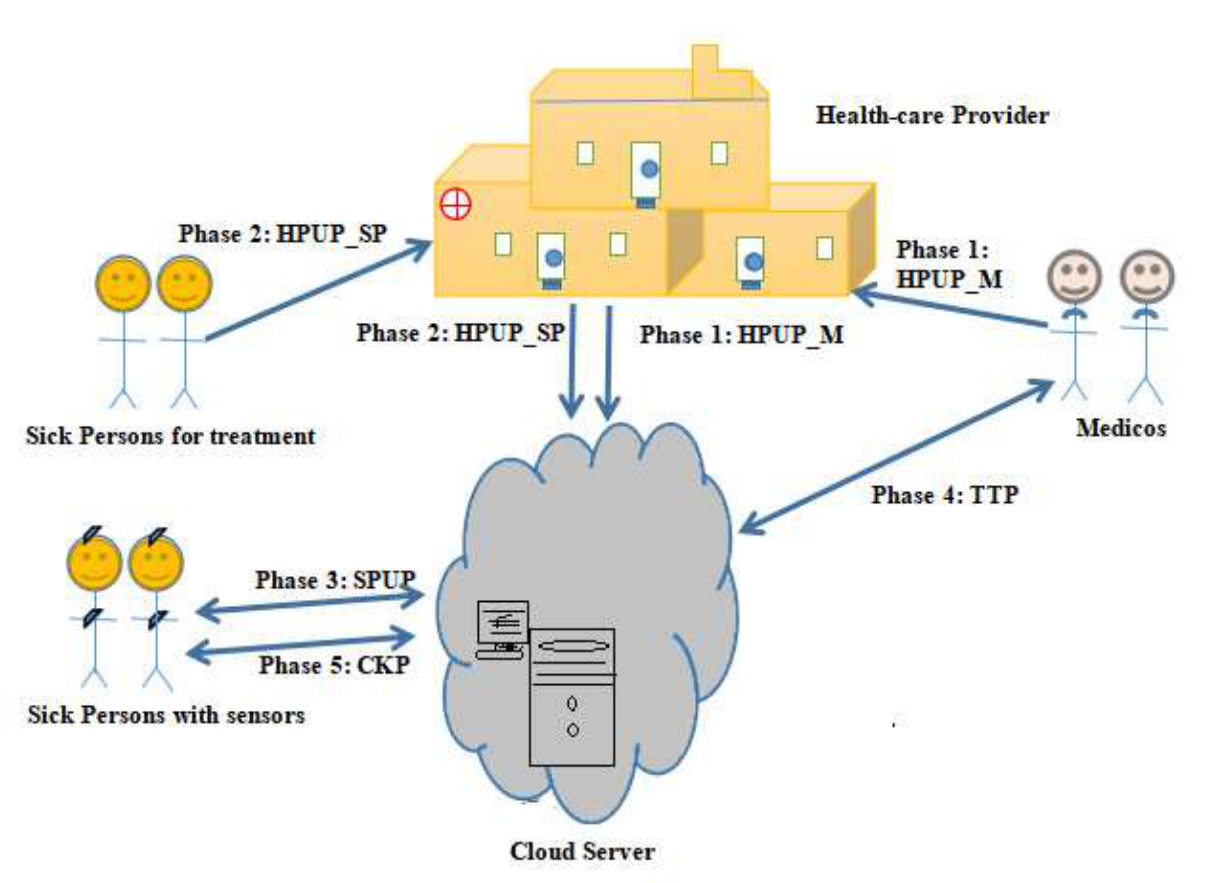
Figure 4. Cloud-based Secure